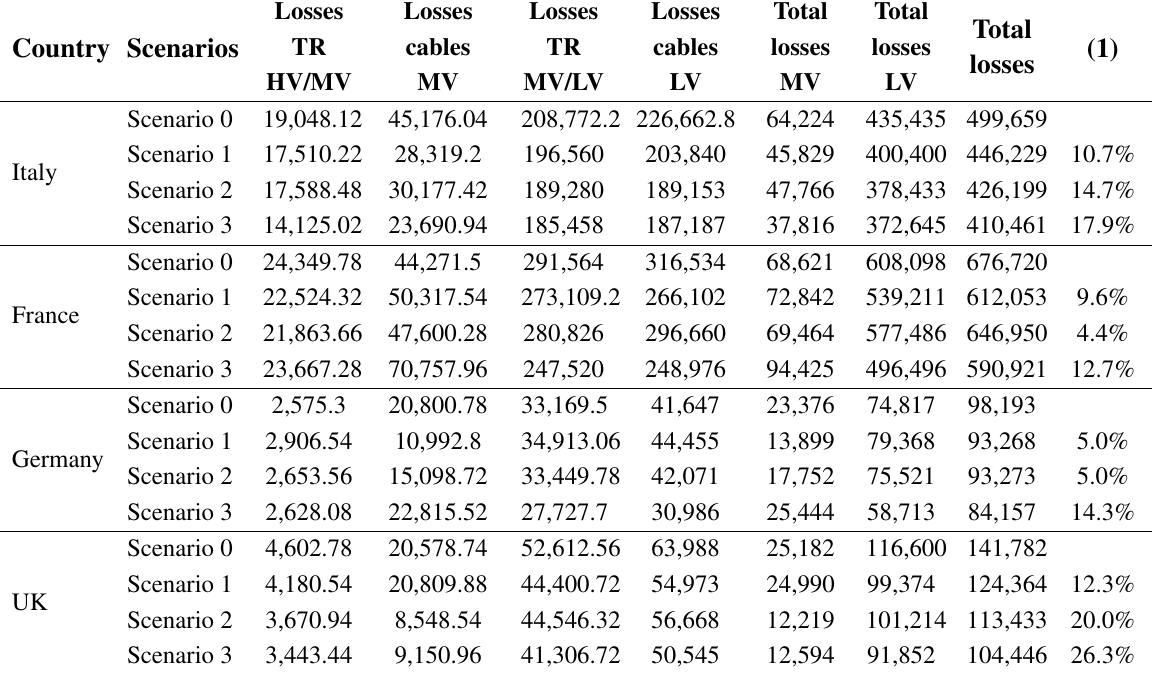
Table 6. Grid simulator results (1)-Loss saving % in comparison to Scenario 0; all losses are in kW h/km 2 .